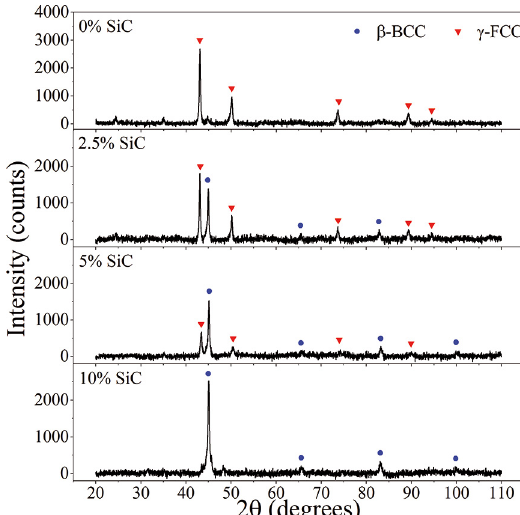
Figure 5: XRD patterns of sintered composite AlCoNi-SiCnp samples as a function of SiCnp content.